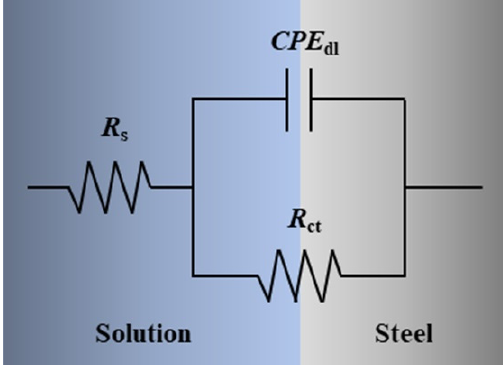
Figure 14. Equivalent circuits.